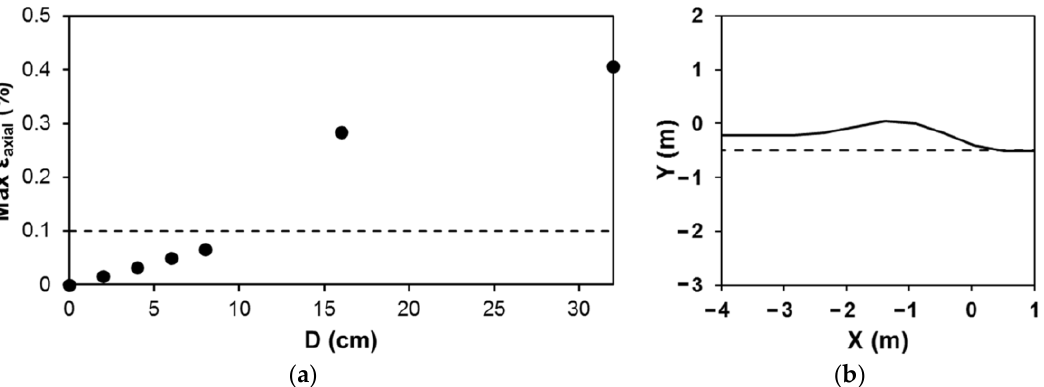
Figure 12. ( a ) Maximum axial strains of the submarine telecommunication cable for different net bedrock displacements, and ( b ) actual displacement of the cable at the fault rupture zone.